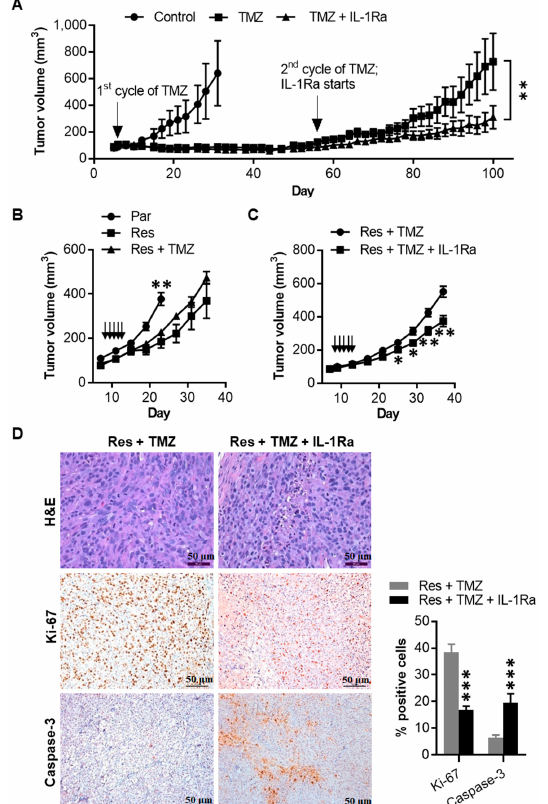
Figure 7. IL-1Ra inhibits TMZ-resistant 1205Lu tumor growth in vivo. ( A ) Tumor growth curve of 1205Lu parental cells subcutaneously injected in mice, treated with a TMZ cycle or 10% DMSO (Control) intraperitoneally (indicated by arrow), and further treated with a second cycle of TMZ together with saline or IL-1Ra (daily subcutaneous injection, starting with the second cycle of TMZ and being kept until the end of the experiment on day 100). Data are expressed as the mean ± SEM. n = 4 tumors (Control), 10 tumor (TMZ), or 10 tumors (TMZ + IL-1Ra). ( B ) Tumor growth curve of 1205Lu parental cells (Par), resistant cells (Res) injected subcutaneously in mice, treated with a cycle of TMZ or 10% DMSO as vehicle control (daily intraperitoneally for five days, indicated by arrows). Tumor growth was monitored for 23 or 35 days (parental or resistant tumors, respectively). Data are expressed as the mean ± SEM. n = 8 tumors per each group. ( C ) Tumor growth curve of 1205Lu